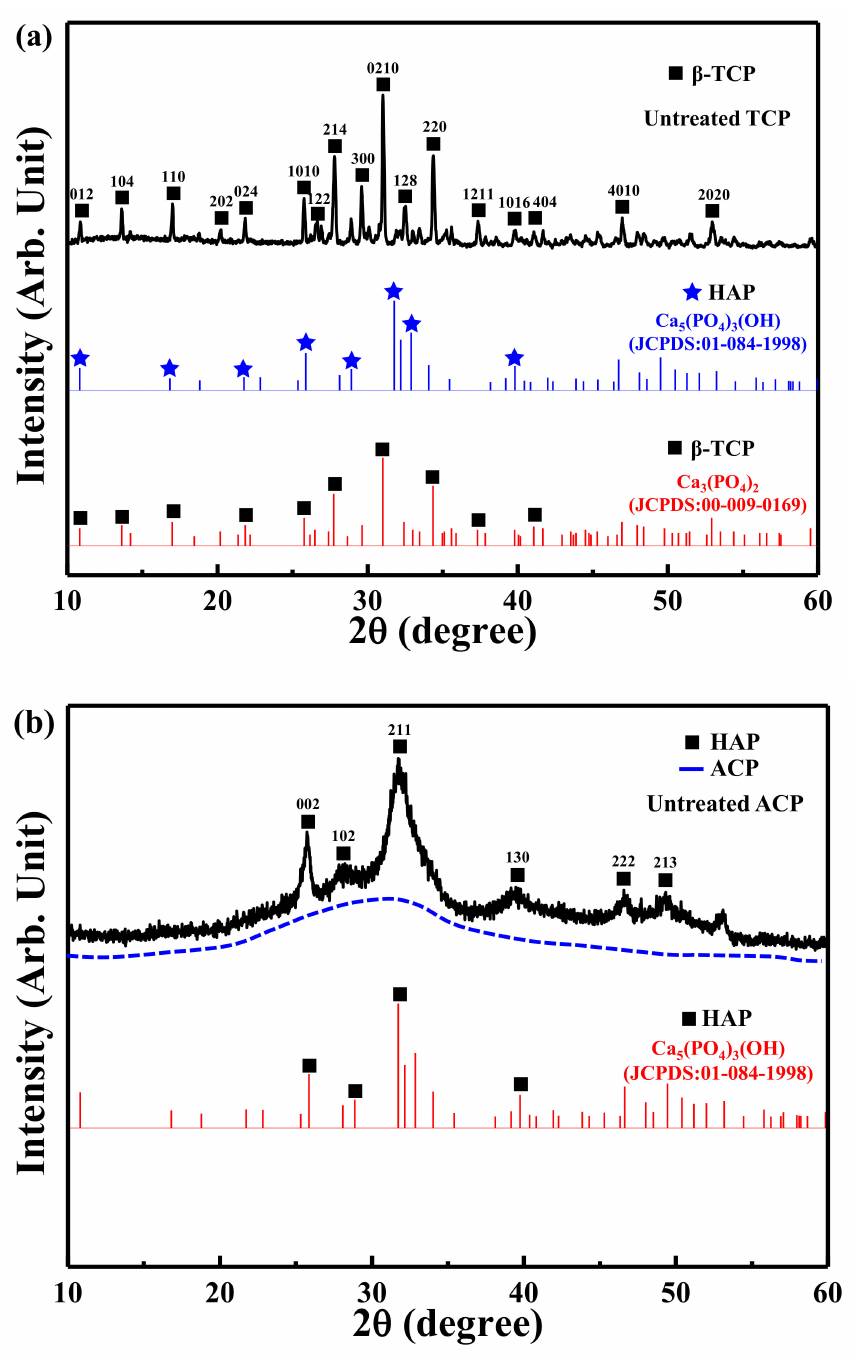
Figure 1. XRD patterns of ( a ) untreated tricalcium phosphate (TCP) powder and ( b ) untreated amorphous calcium phosphate (ACP) powder. ( a ) Peaks corresponding to 0210, 128, and 220 of the TCP (black cube), respectively. The blue star (HAP) is not visible, indicating that most of the raw materials were β -TCP. ( b ) A broad diffraction peak, which is characteristic of the amorphous state of ACP (blue line). Only one peak corresponding to 211 of the HAP (black cube) exists, indicating that most of the raw materials were ACP. The x -axis of the spectra is the defined diffraction angle between the incident and the reflected x-ray; the y -axis is the extent of the crystallinity of the particular plane.